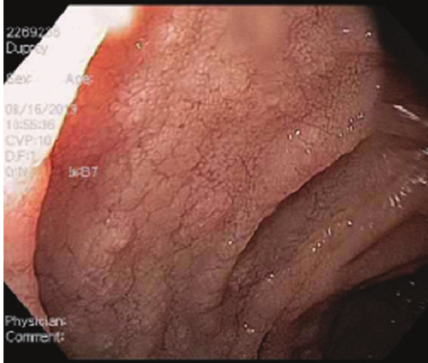
Figure 1: 2nd portion of the duodenum: Nodularity, edema,